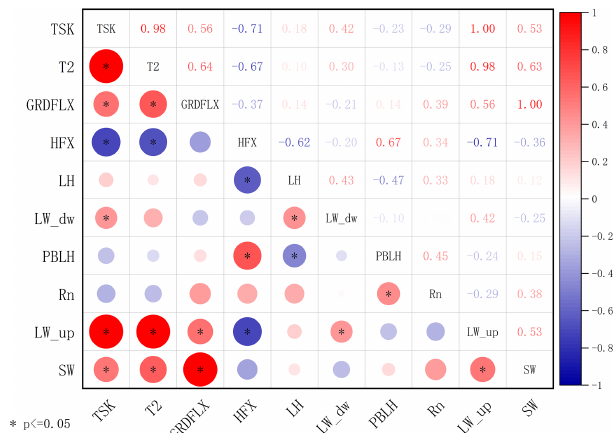
Figure 5. Pearson correlation coefficient between 10 variables of simulation results by WRF with 2018 land use dataset in CCUA. The asterisk indicates the variables that were judged to be signifi- cant after inspection ( p ≤ 0 .